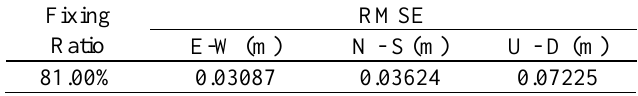
Fig. 11. Plot of the RTK horizontal position components from single frequency GPS module observation on open sky area The results of dual frequency GPS module measurement in open sky area are presented in Table 2. In open sky area the fixing ratio value is 81% with RMSE of 0.04356m, 0.03087m, 0.03624m and 0.07225m for the Easting (E-W ), Northing (N- S) and Up (U-D) component as presented in Table 2. The plot of the RTK solution of horizontal position components can be seen in Fig. 12. Table 2. Statistic of single frequency observation on open sky area